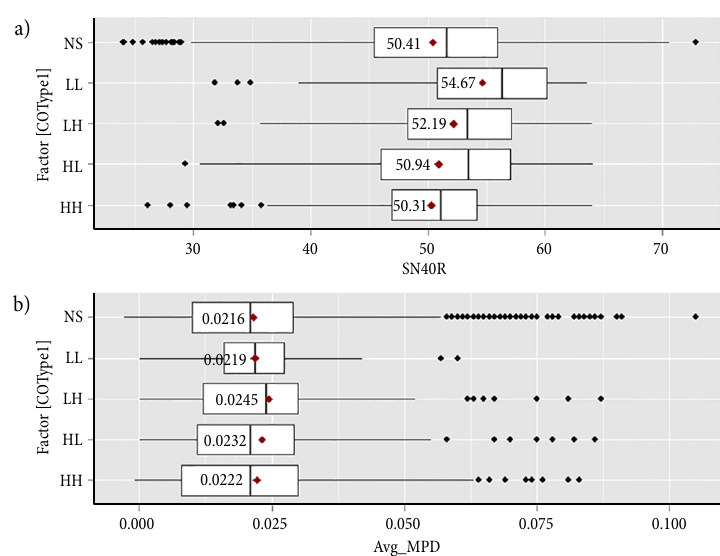
Fig. 5. Boxplots of pavement friction characteristics and types of hotspots of weather-related